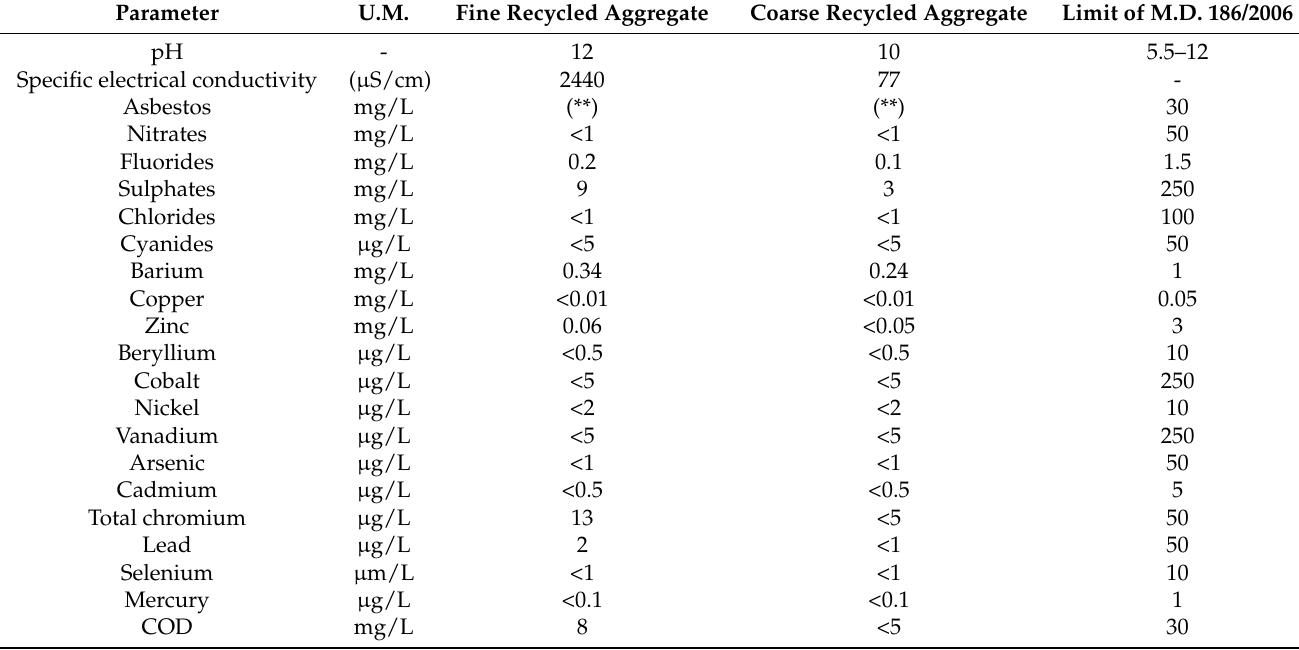
Table 4. Leachate concentrations from fine and coarse recycled